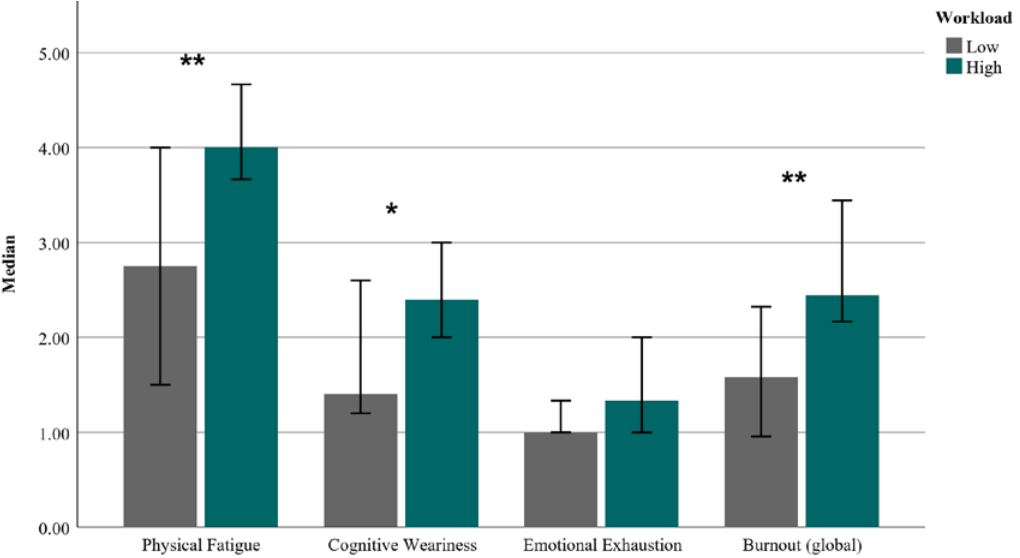
Figure 2. Between group comparison for the scores of physical fatigue, cognitive weariness, emotional exhaustion and global burnout. The ROC curve (Figure 3) coordinates indicated that the best cut-off of daily number of patients treated was 31 patients and the best cut-off of daily working hours was 6.75 hours. The AUC for the number of patients treated daily was 0.742 (95% CI: 0.580 to 0.903; p = 0.011) and the AUC for the daily working hours was 0.619 (95% CI: 0.439 to 0.799; p =